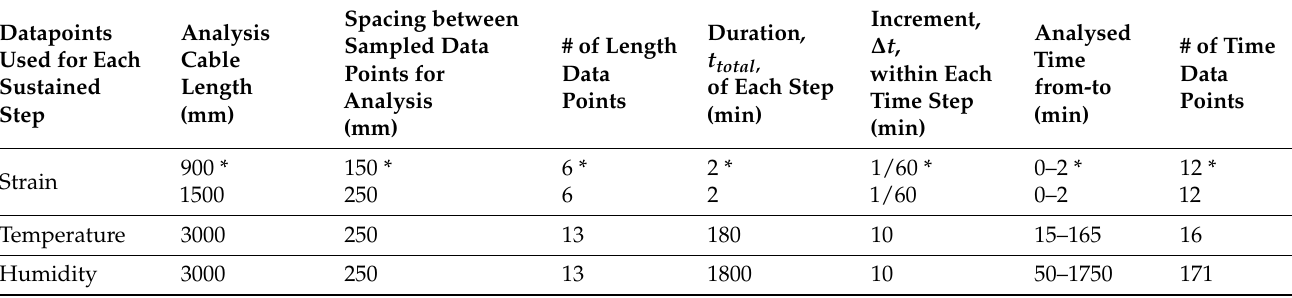
Table 2. Calibration analyses: spatial and time increments used for the linear regression